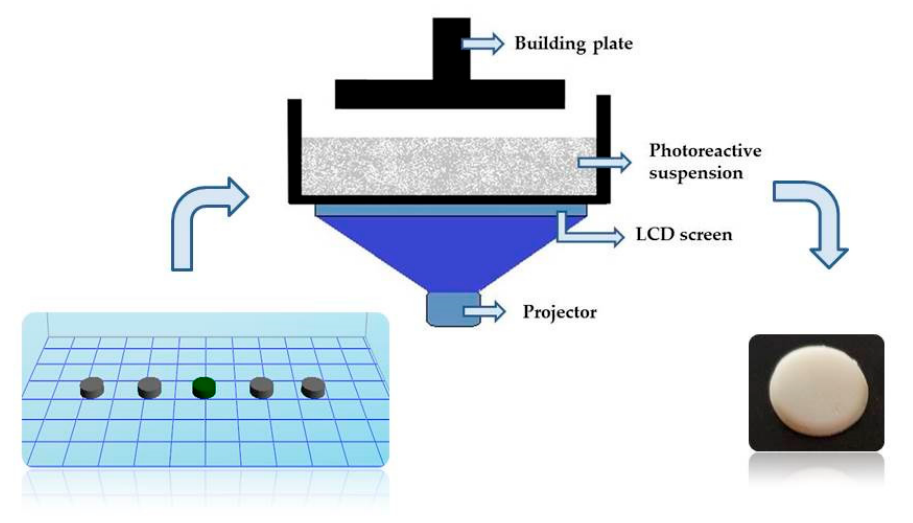
Figure 1. Illustration of the 3D DLP printing.